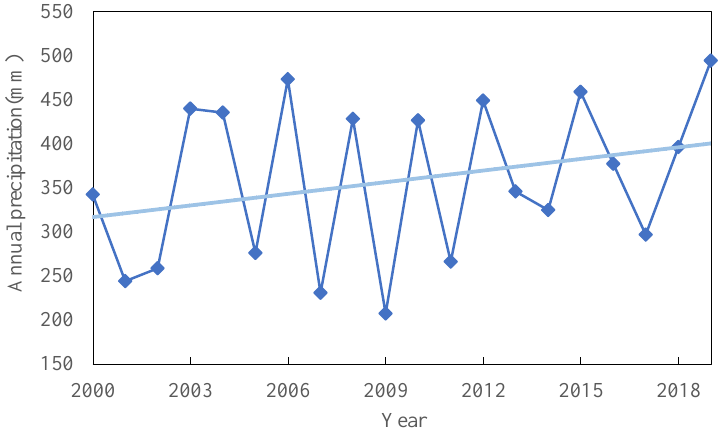
Figure 17. Annual precipitation change curve.